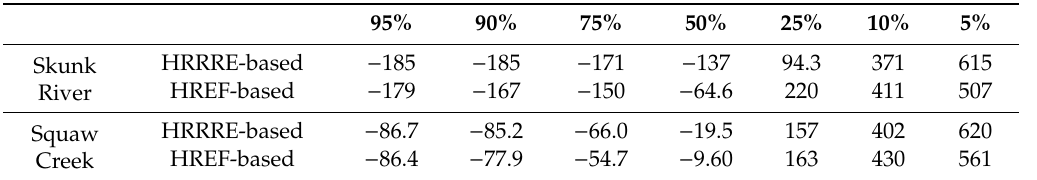
Table 5. Error (m 3 s − 1 ) for Skunk River and Squaw Creek ensemble streamflow predictions for di ff erent probability of exceedance values for the 14 June event.